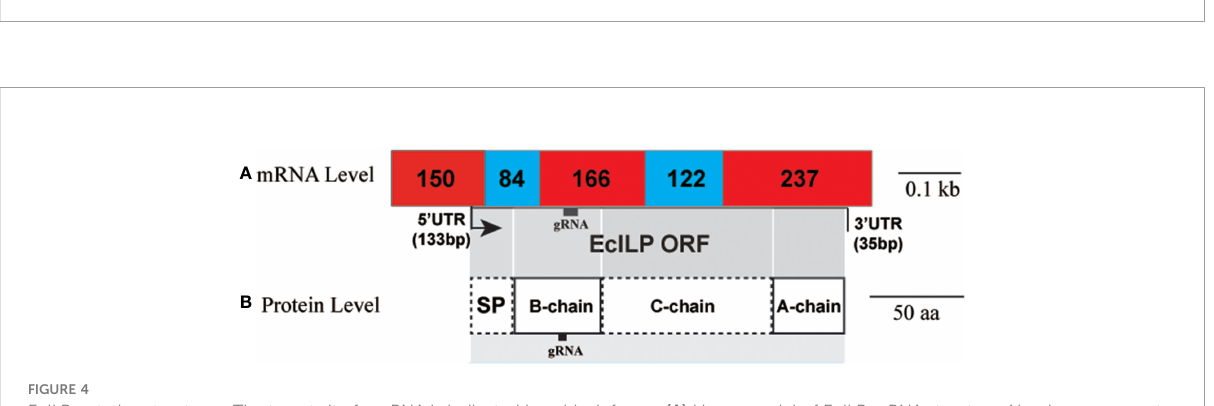
FIGURE 4 EcILP putative structures. The target site for gRNA is indicated by a black frame. (A) Linear model of EcILP mRNA structure. Numbers represent the length of exons. (B) Linear model of EcILP amino acid sequence. The correspondence between mRNA structure and amino acid sequence is indicated by one-to-one